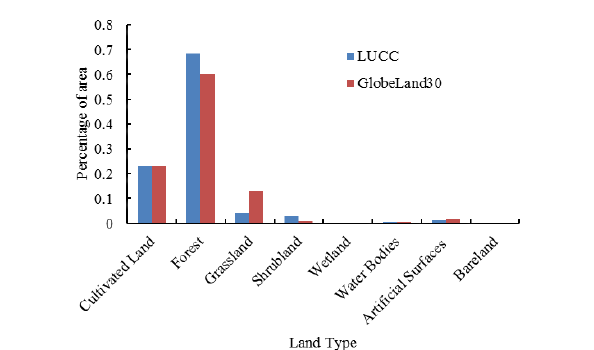
Figure 5. Comparison of GlobeLand30 and China land use data in southern Jiangxi Province